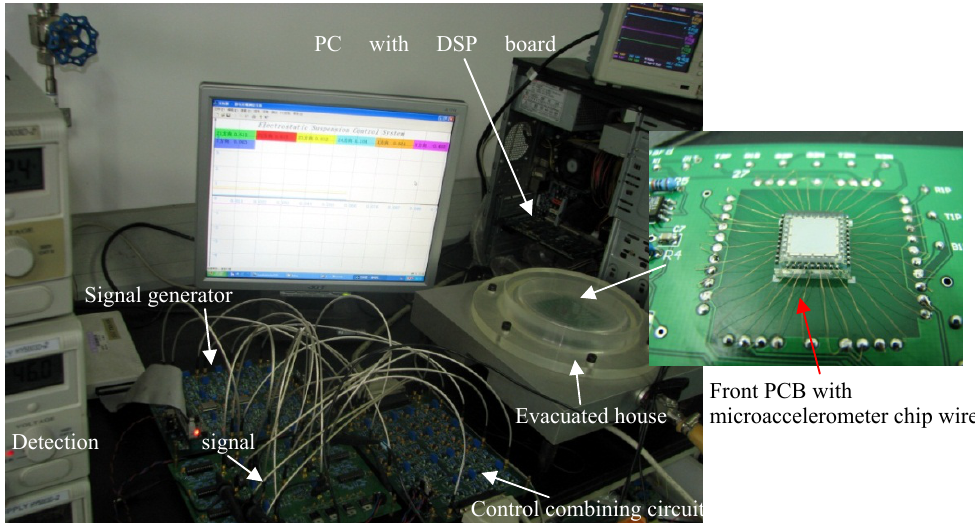
Figure 13. Levitation experiment system for the fabricated